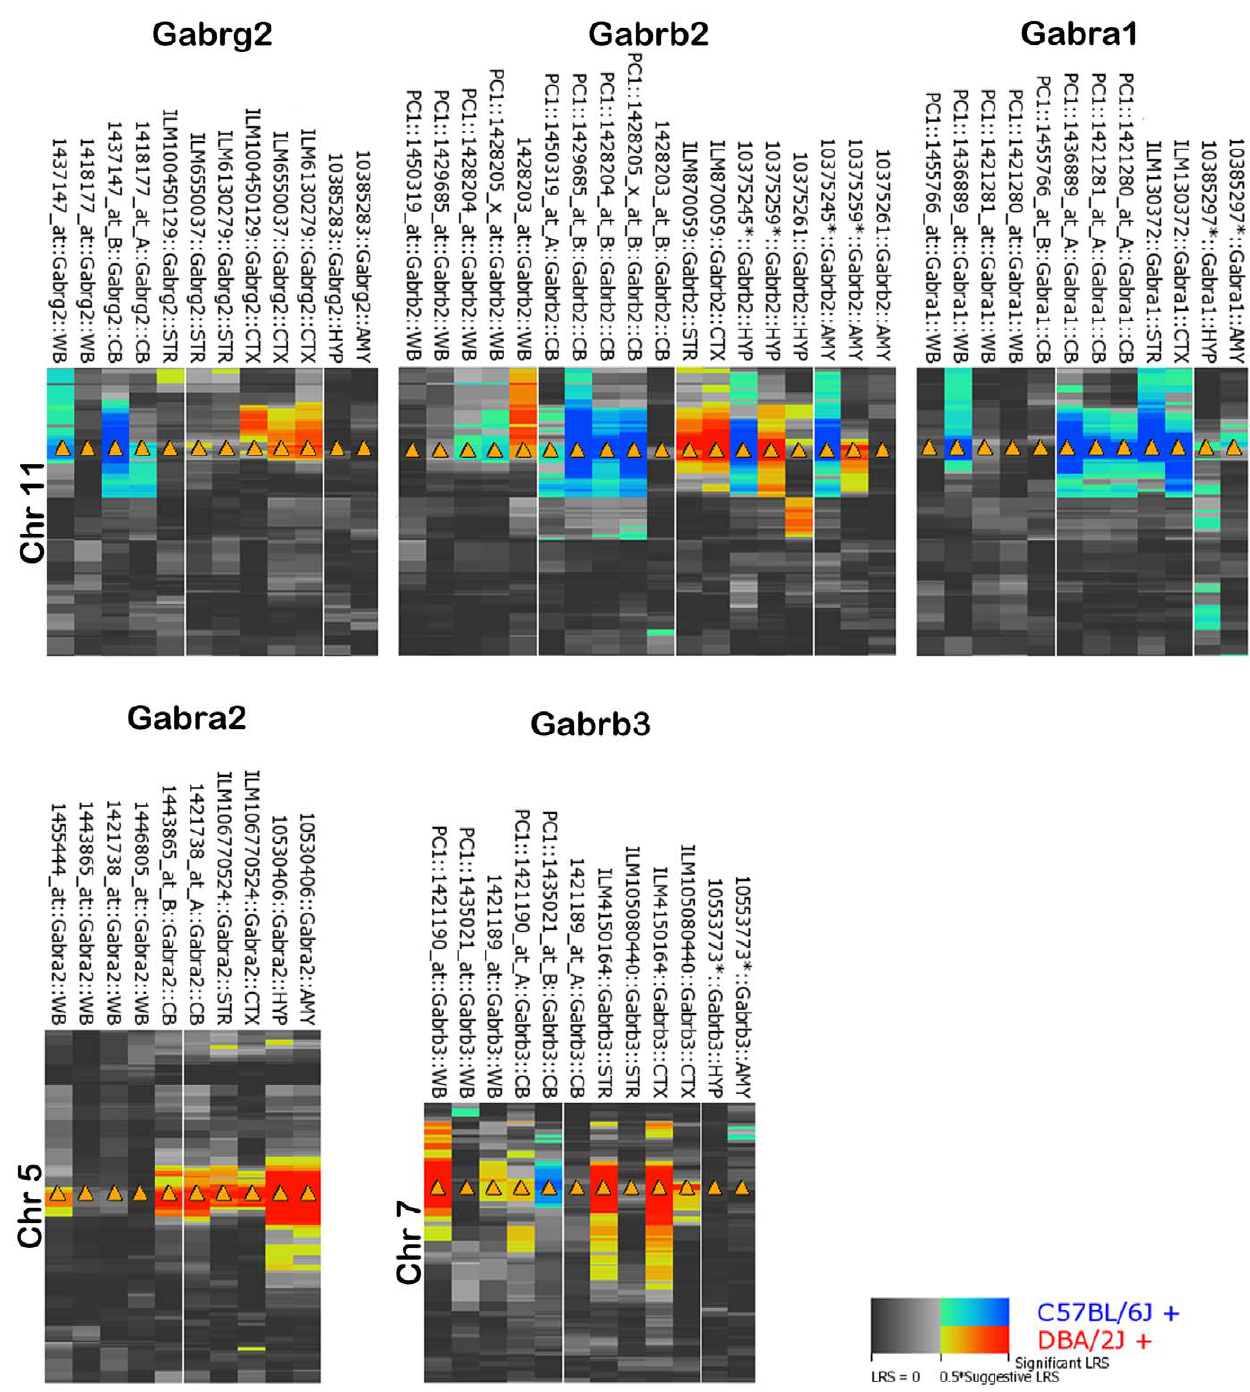
Figure 2. Consistency of cis modulation across tissues. Genetic regulation of the 5 subunits regulated by strong cis eQTLs in the hippocampus was compared across three different platforms Affymetrix M430 (WB=whole brain, CB=cerebellum), Affymetrix MoGene 1.0 ST (AMY=amgydala and HYP=hypothalamus), and Illumina (CTX=neocortex, STR=striatum). Each probe set was required to have a mean expression of at least 8 in each tissue database. Blue and red indicate an association between the B6 and D2 allele at each locus and higher probe set expression, respectively. The more intense hue indicates a greater association and a corresponding increase in significance. For all data except the HYP and AMY, probes overlapping SNPs were filtered out and a principal component analysis was performed on remaining probes to capture a component (PC1) explaining the majority of the variation in probe set expression. Percent of variance explained by each PC1 ranged from ( , 45% to 95%). Because of the large number of probes included for measurement in the HYP and AMY, a probe level analysis was not possible. Some probe sets (indicated by *) contained 1 to 3 probes overlapping a variant. It is hard to predict the overall effect of these variants but, in general, those probe sets with SNPs that have higher expression associated with the B6 allele (blue) have a higher chance of being false due to SNP artifacts. Cis modulation of expression across tissues is most consistent for Gabra2 and Gabra1 .